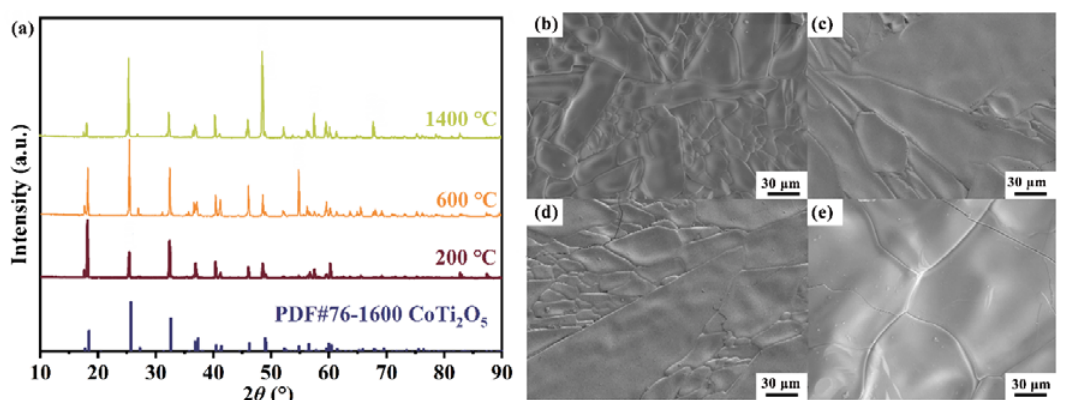
Fig. 13 (a) XRD patterns of high-entropy (Mg,Co,Ni,Zn)Ti 2 O 5 after heat treatment at 200, 600, and 1400 ℃ for 20 h. SEM images of high-entropy (Mg,Co,Ni,Zn)Ti 2 O 5 (b) before heat treatment and after heat treatment at (c) 200 ℃ , (d) 600 ℃ , and (e) 1400 ℃ .